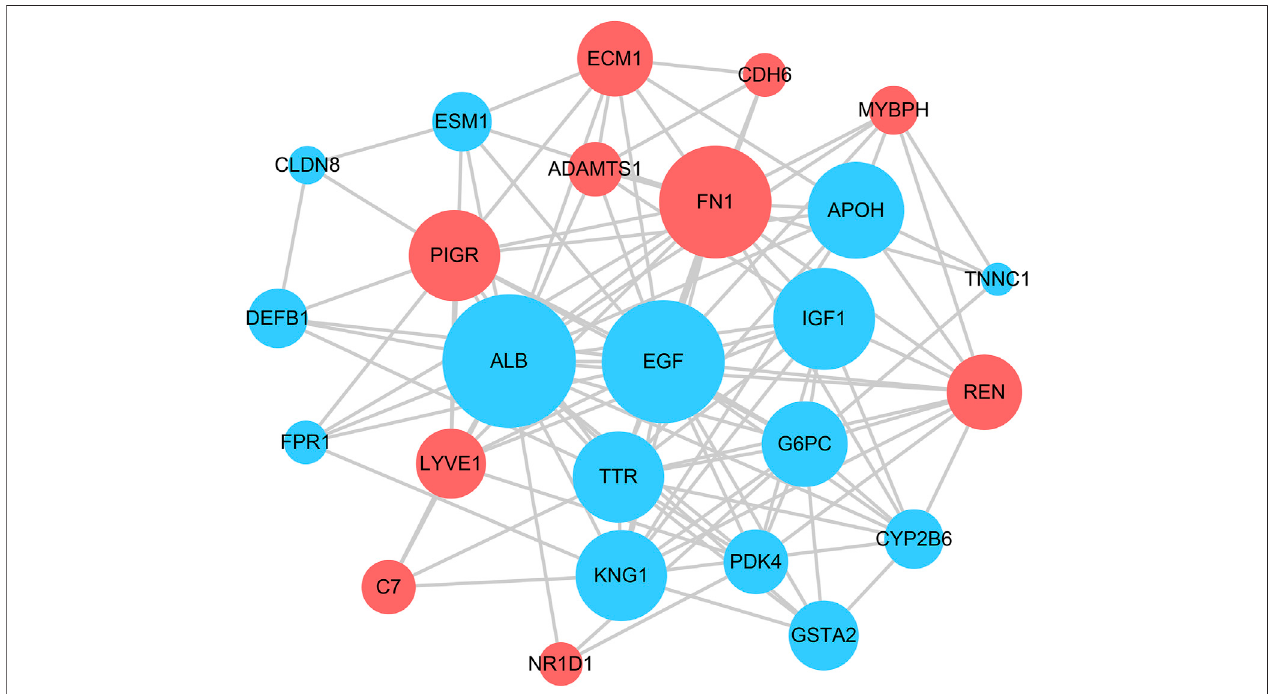
FIGURE 4 | Protein – protein interaction network constructed with the differentially expressed genes. Red indicates that gene expression is upregulated; blue indicates that gene expression is downregulated.